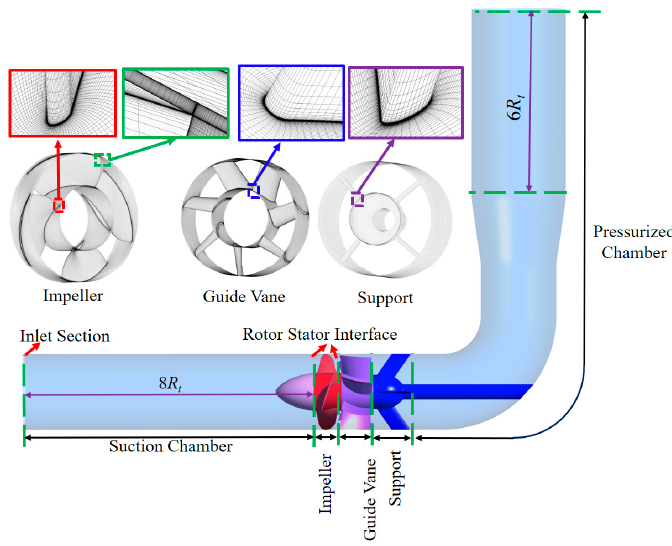
Figure 6. Flow domains and grids.